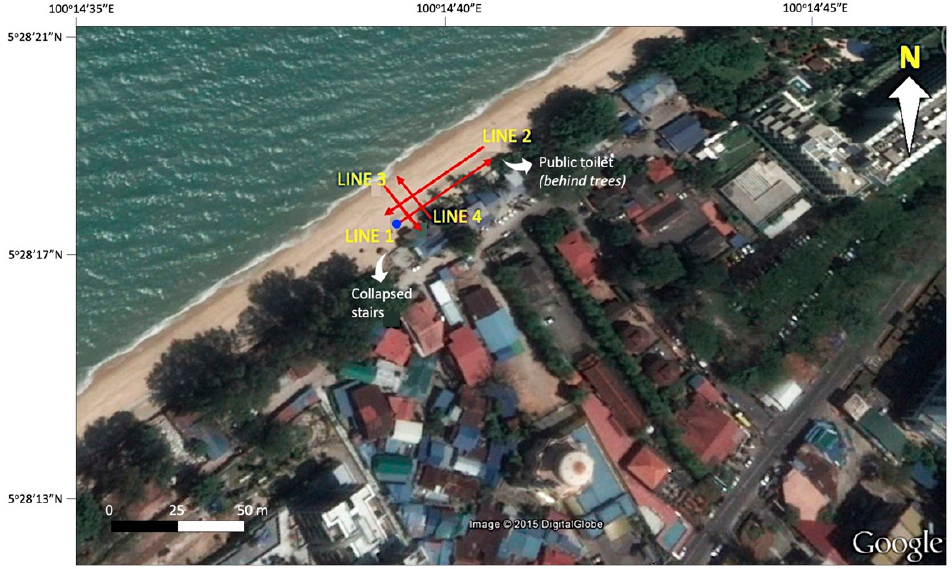
Figure 2. Survey lines of GPR at site 1, Batu Ferringhi, representing natural coastal landform, plotted on Google Earth (2015), Batu Ferringhi, Penang, Malaysia. The coordinates for the initial point of survey lines ( • ) is 05°28 ′ 17.24 ″ N and 100°14 ′ 39.00 ″ E. DigitalGlobe 2015. http://earth.google.com (accessed on 3 February 2015).